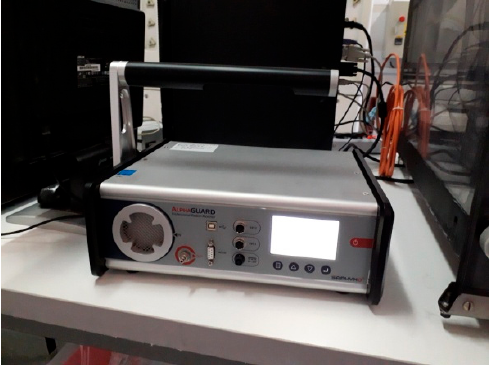
Figure 1. The new radon monitor AlphaGuard DF2000 (IFIN-HH/LMRI reference